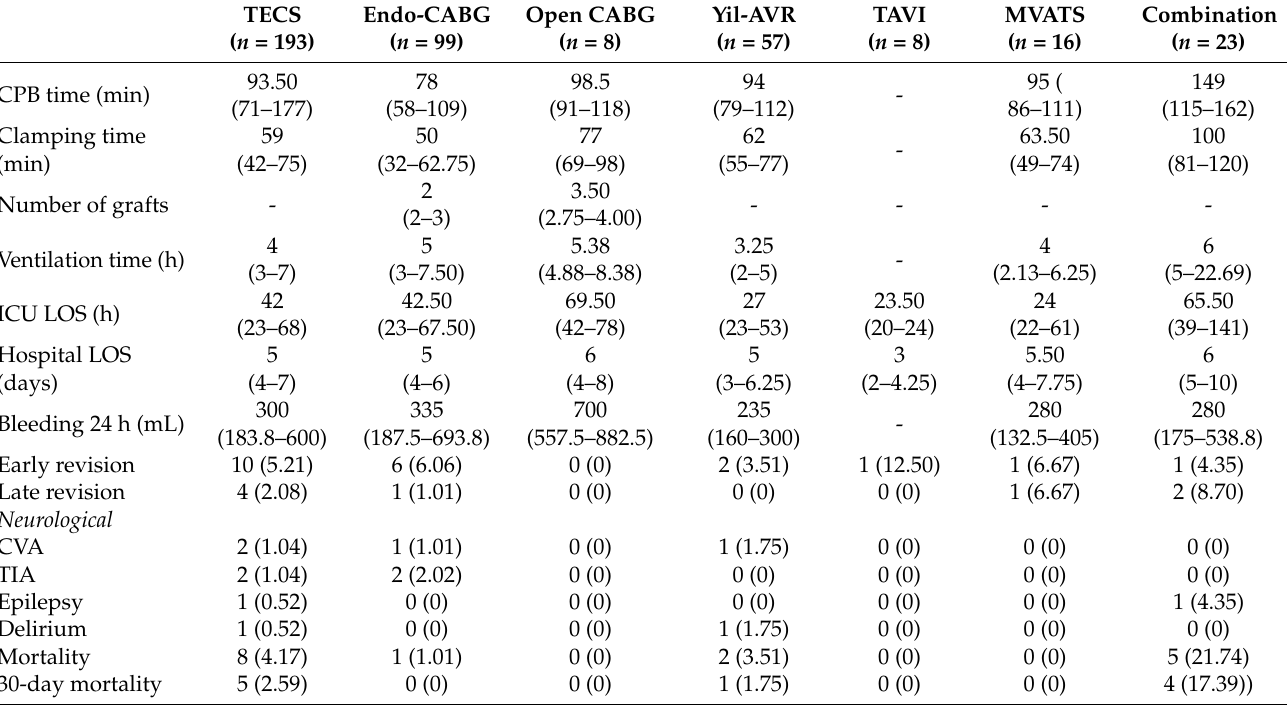
Table 2. Clinical outcomes. Data is represented as n (%) or median